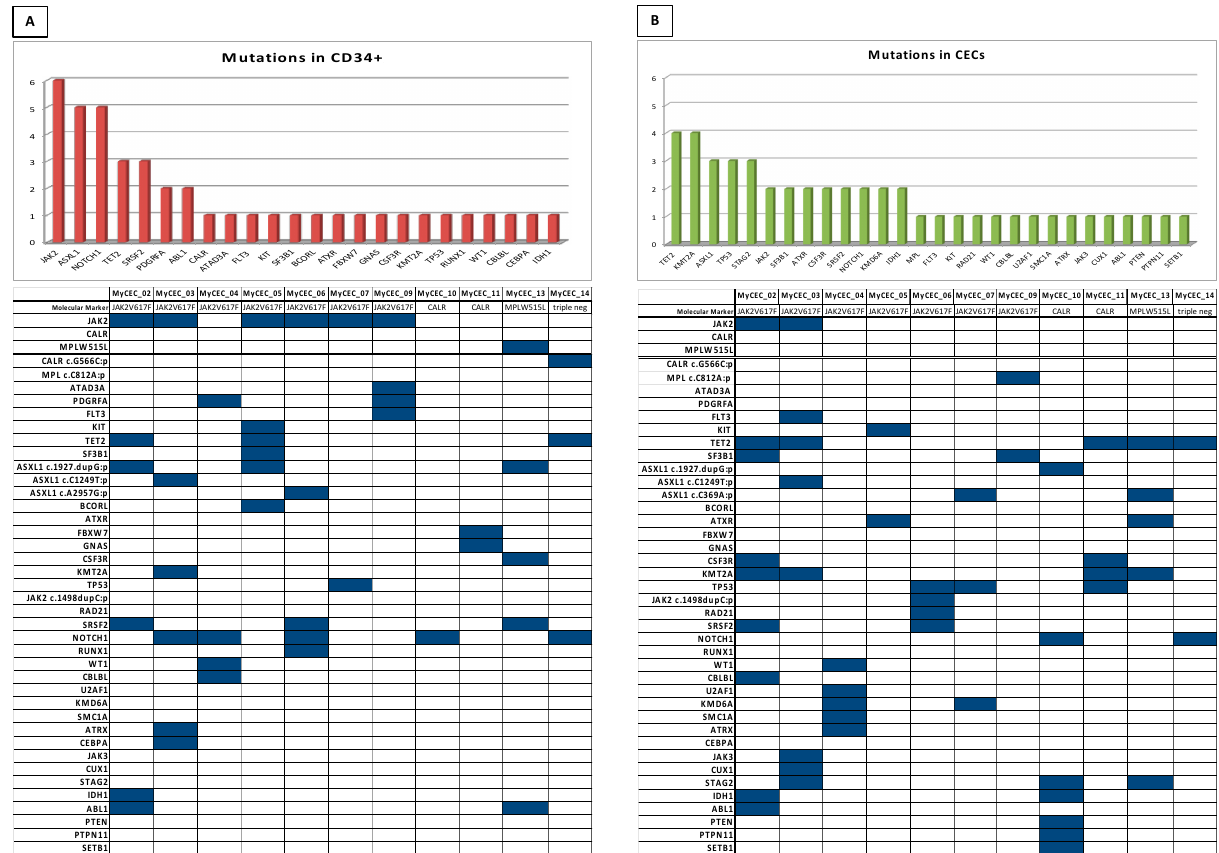
Figure 3. Molecular alterations on CD34 + -HSPCs and CECs. Mutated gene frequency and Molecular alterations discovered on CD34+-HSPCs ( A ) and CECs ( B ). On the top the frequency of mutated genes, while on the bottom the table with all the mutated genes in each patient.